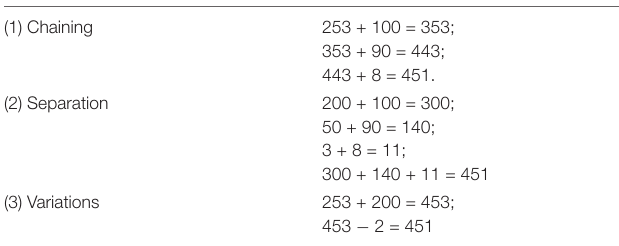
TABLE 1 | Strategies for mental calculation used in The Netherlands